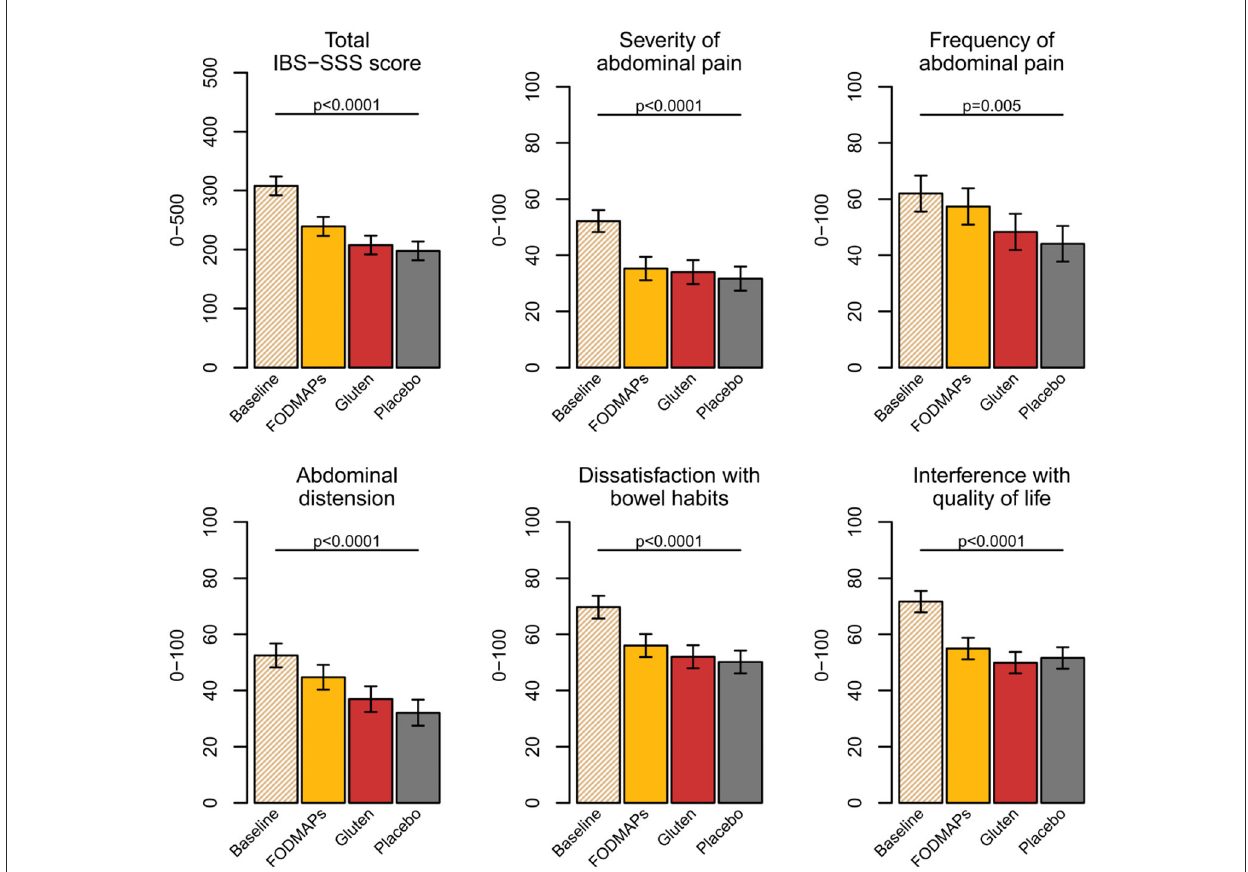
FIGURE1 IBS-SSS scores at baseline and after the FODMAPs, gluten, and placebo interventions. Data presented as estimated marginal means, confidence interval (%) and p -value from type 3 test. FODMAPs, fermentable oligo-, di-, monosaccharides, and polyols; IBS-SSS, Irritable bowel syndrome Severity Scoring System. This figure from doctoral thesis by Elise Nordin Chalmers, University Technology